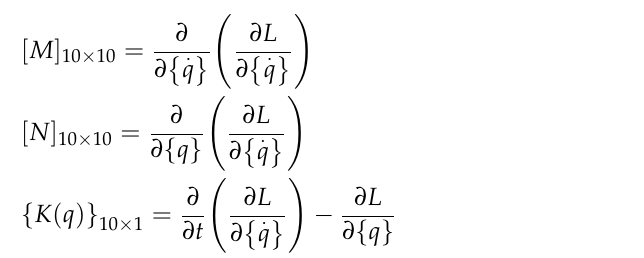
Figure 7. Schematic view of a very small component of the blade and two components of the gravity force. By defining the following matrices, one can find the dynamic equation of motion by the Lagrange